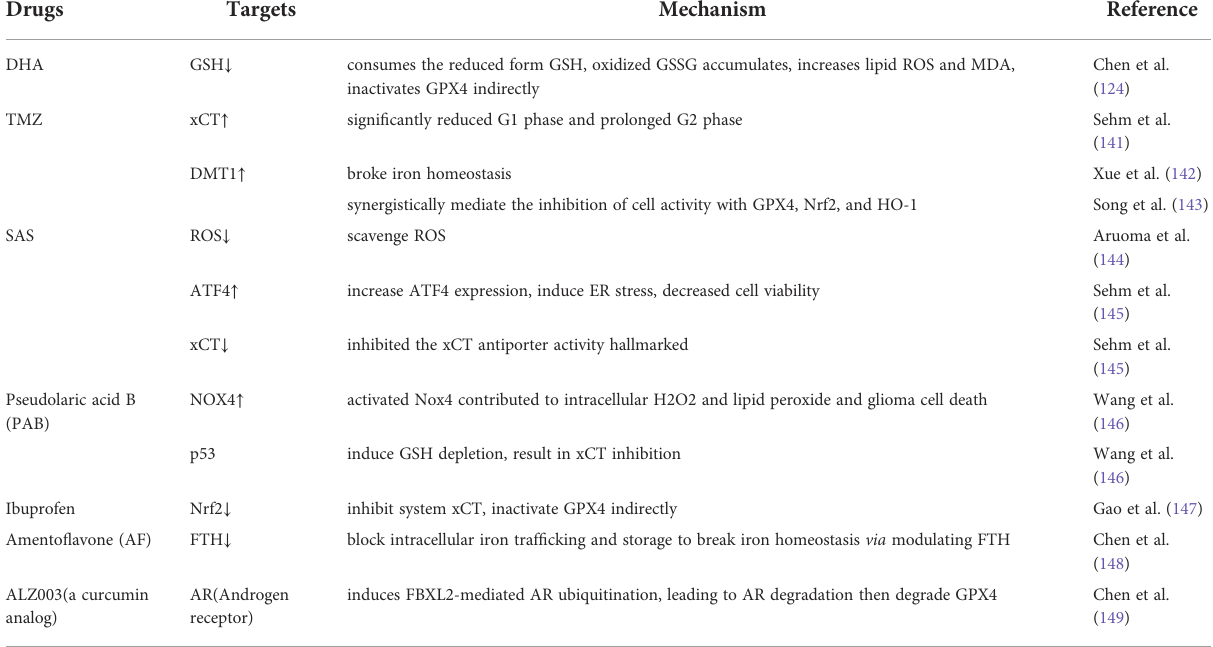
TABLE 2 Therapeutic Drugs towards Glioma Treatment by targeting Ferroptosis.